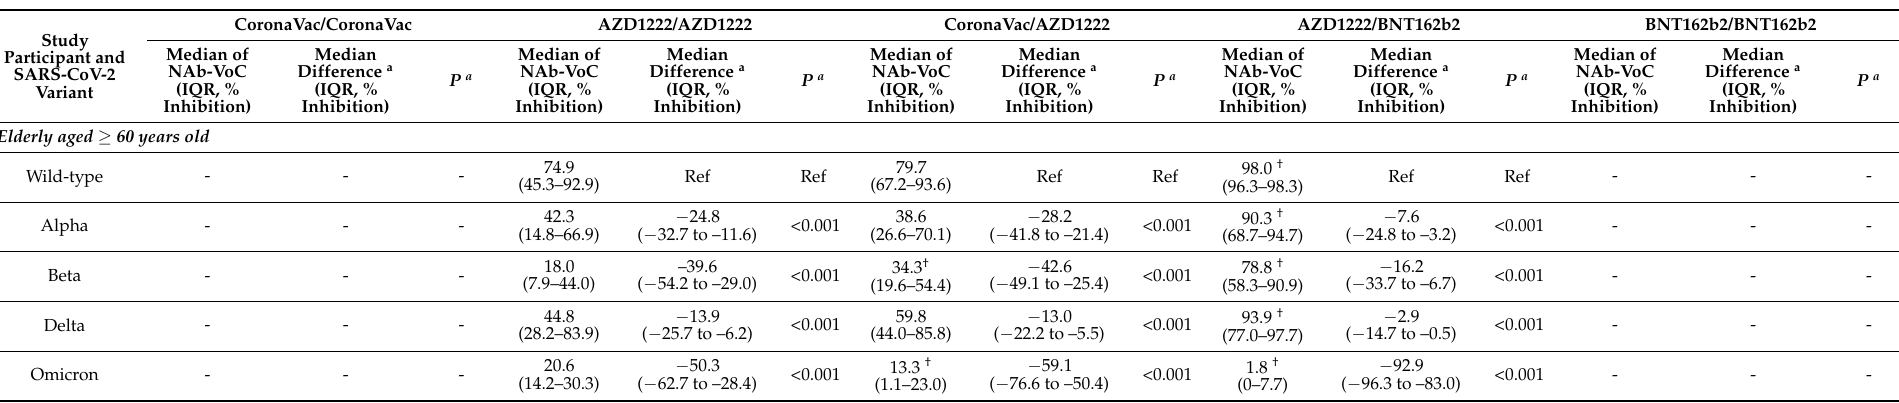
compare the medians of neutralizing antibody, based on the in-house surrogate virus neutralization test, between wild-type SARS-CoV-2 and the indicated variant of concern within each COVID-19 vaccine regimen; * Indicates a significant difference ( p < 0.05) of the median of neutralizing antibodies, based on the in-house surrogate virus neutralization test, against wild-type and other circulating variants of concern of SARS-CoV-2 after the completion of the primary series of an indicated COVID-19 vaccination compared with the homologous CoronaVac vaccine regimen, evaluated by the median regression analysis; † Indicates a significant difference ( p < 0.05) of the median of neutralizing antibodies, based on the in-house surrogate virus neutralization test, against wild-type and other circulating variants of concern of SARS-CoV-2 after the completion of the primary series of an indicated COVID-19 vaccination compared with the homologous AZD1222 vaccine regimen, evaluated by the median regression